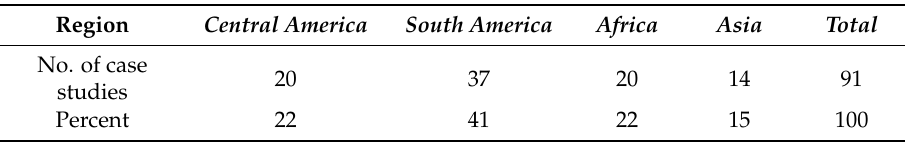
Figure 2. Geographical coverage of micro-level case studies on land-use change across (sub)tropical regions in the period 2000–2015. Table 2. Regional coverage of reviewed micro-level case studies on land-use change across (sub)tropical regions in the period